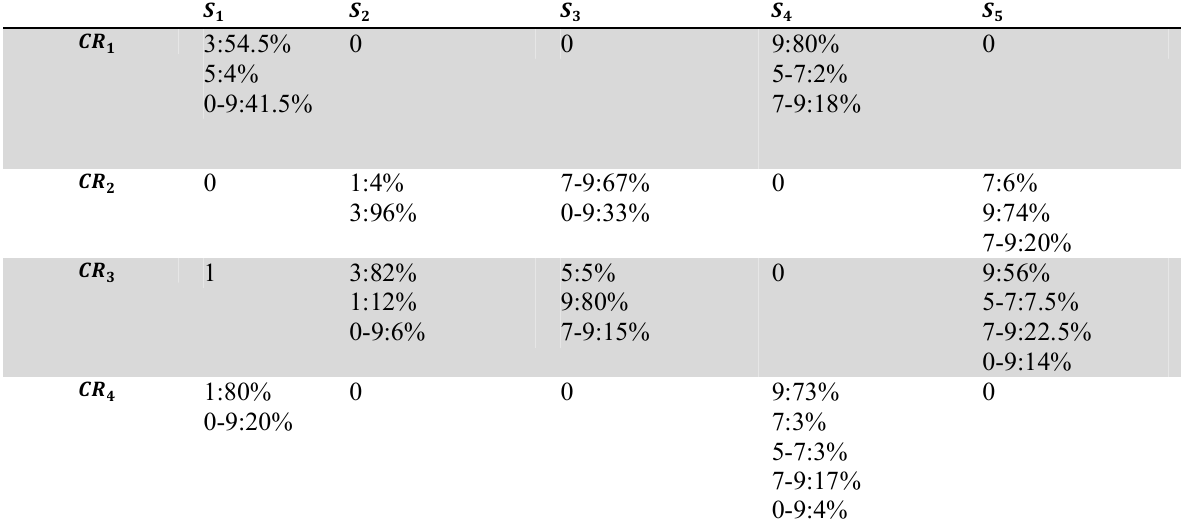
Belief relationship matrix between the Rumlet criteria and five strategies of SWOT